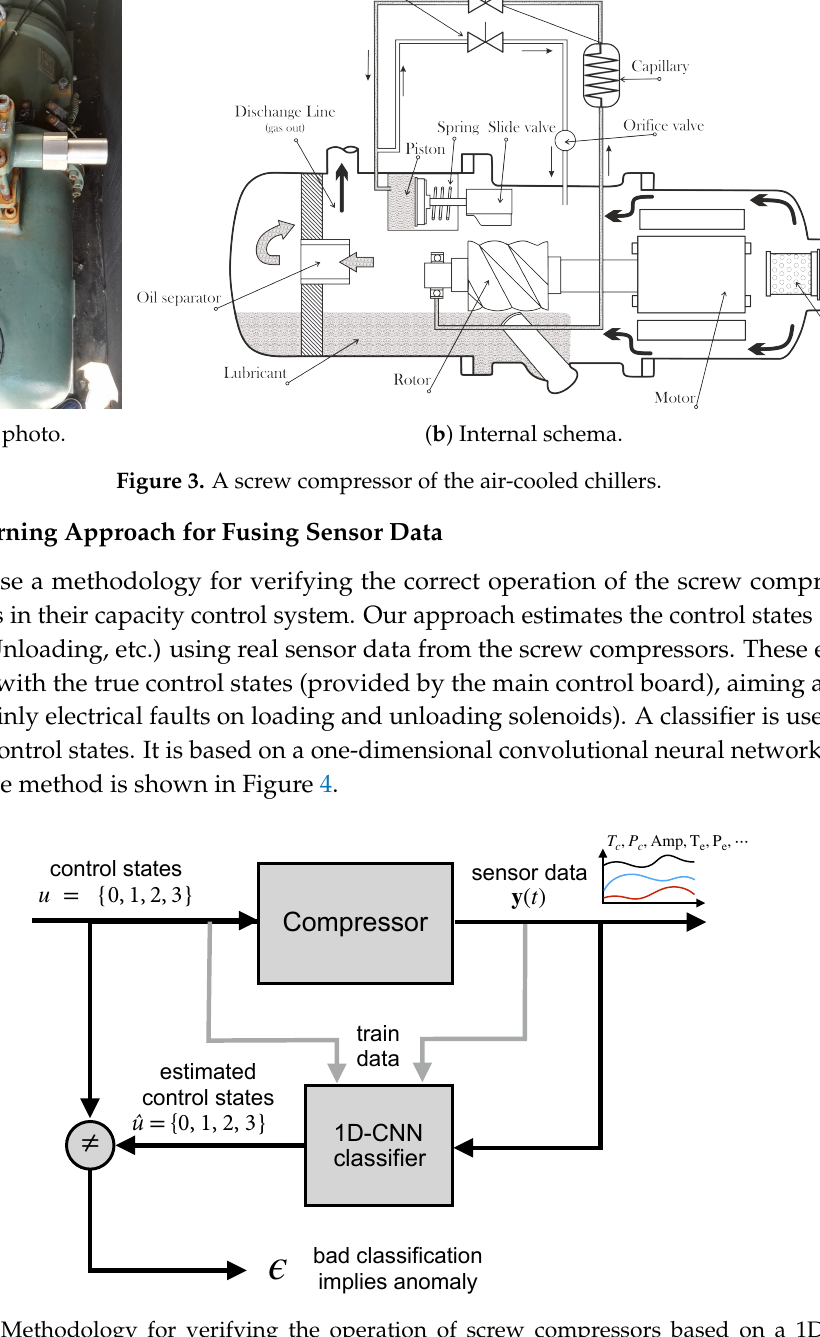
Figure 4. Methodology for verifying the operation of screw compressors based on a 1D CNN (one-Dimensional Convolutional Neural Network)